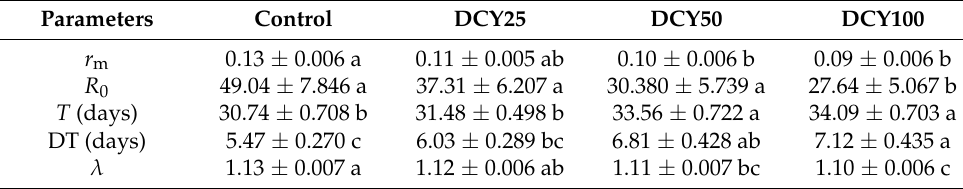
Table 2. Population life table parameters of SBPH fed on rice under laboratory